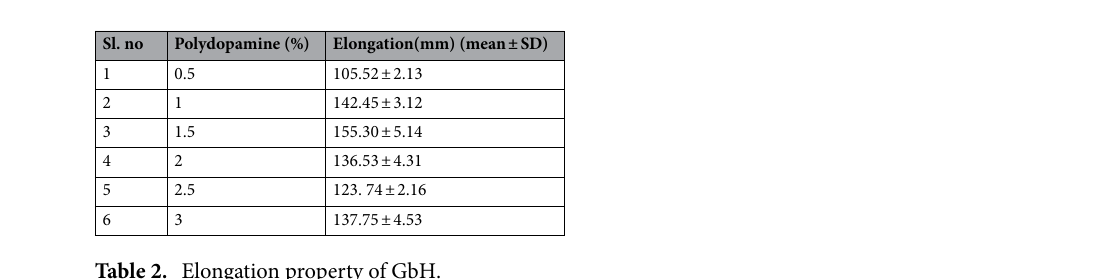
Table 2. Elongation property of GbH.